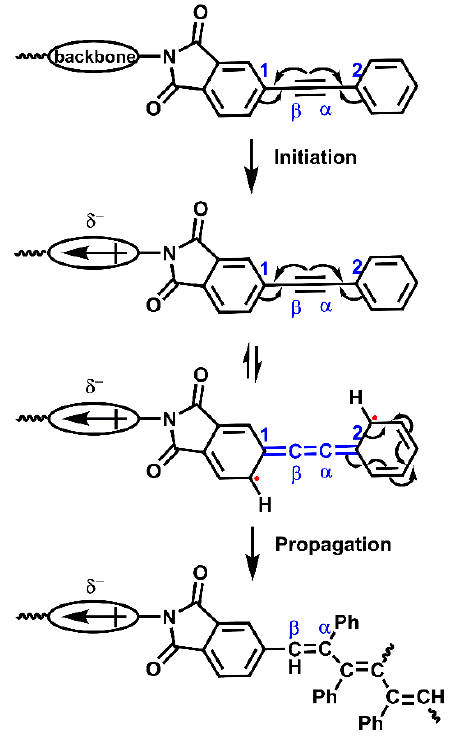
Scheme 3. Free radical cure reaction of PEPA-endcapped oligoimides.